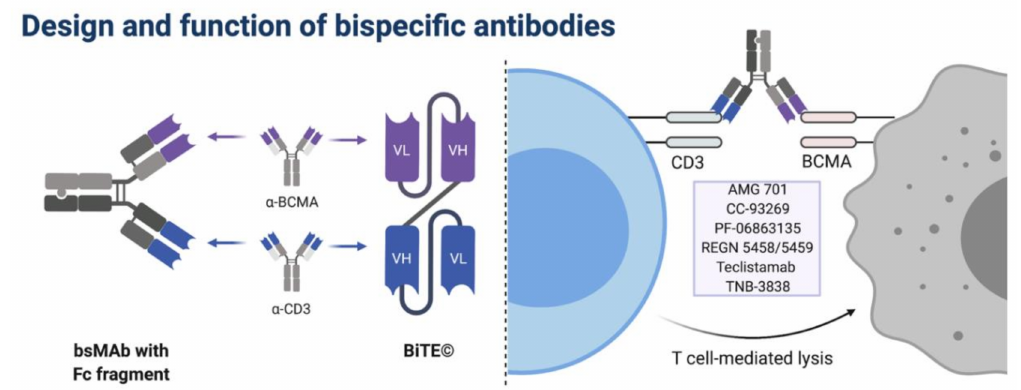
Figure 1. Design and function of bispecific antibodies. Bispecific antibodies connect the antigen-recognizing fragments of two different monoclonal antibodies and lead to binding of CD3 + T cells to cells expressing the target of interest (e.g., BCMA for MM cells). Currently investigated anti-BMCA bispecific antibodies are listed on the right. BCMA, B-cell maturation